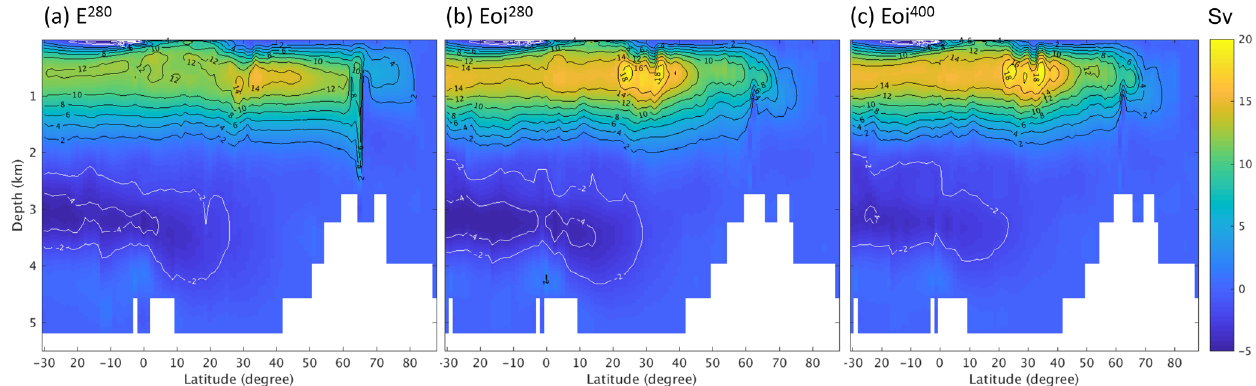
Figure 12. Time-averaged Atlantic overturning circulation for (a) E 280 , (b) Eoi 280 and (c) Eoi 400 . Positive values indicate clockwise